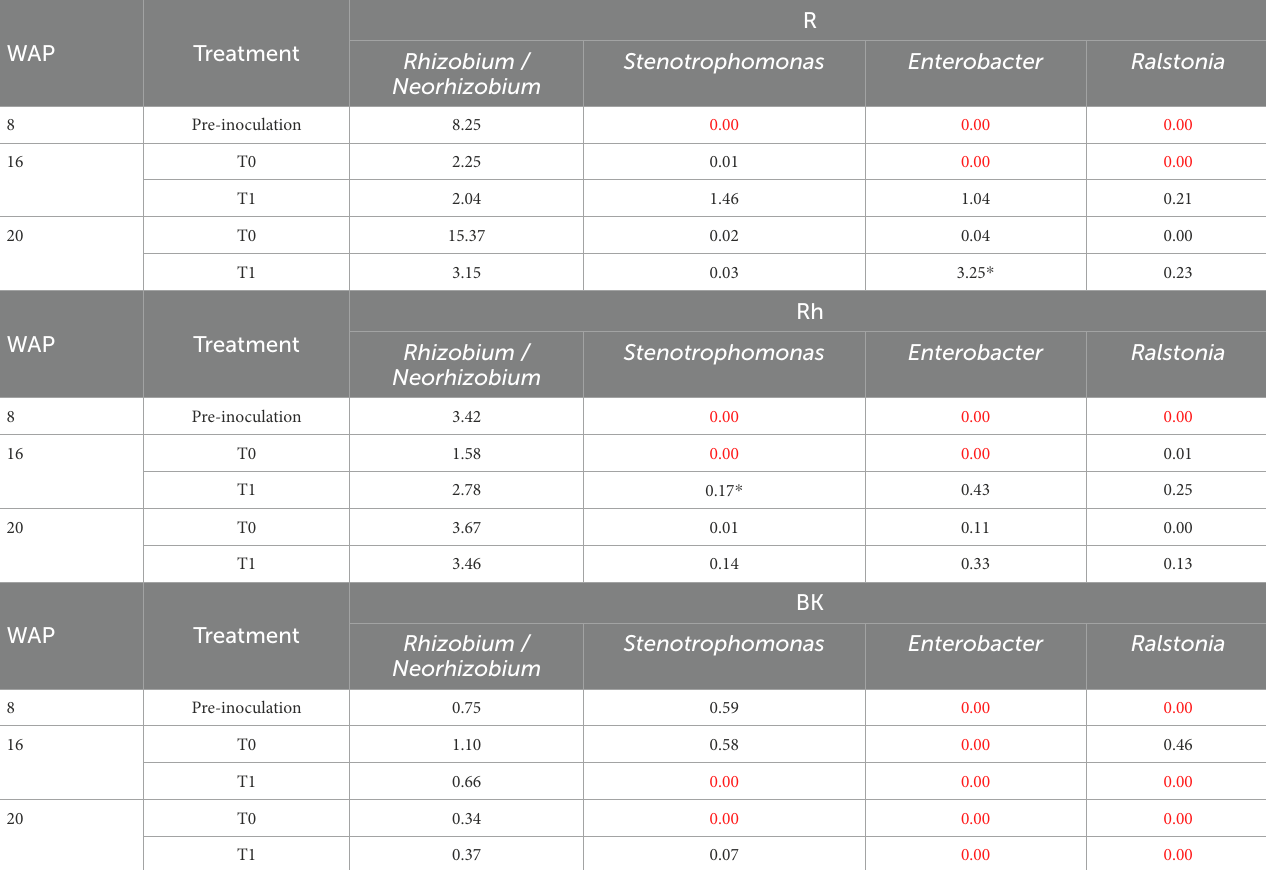
TABLE 3 Relative abundance (percent of total good-quality sequences) of the introduced bacteria in the root (R), rhizosphere (Rh), and bulk soil (BK) samples as affected by inoculation with the synthetic bacterial community.